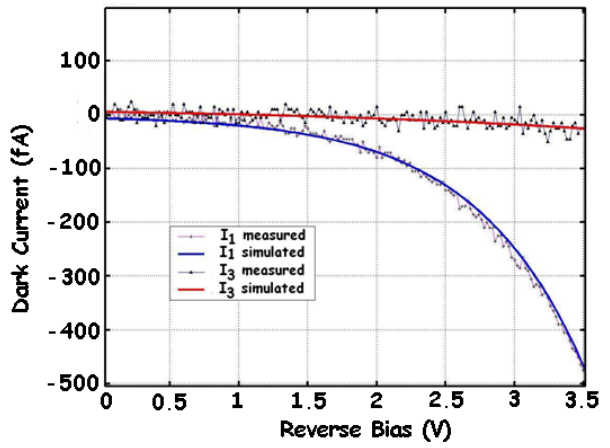
Figure 9. Measured and simulated I–V plots of J µm² BDJ at 300 K